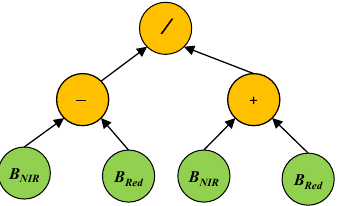
Figure 1. An example GP tree for NDVI.